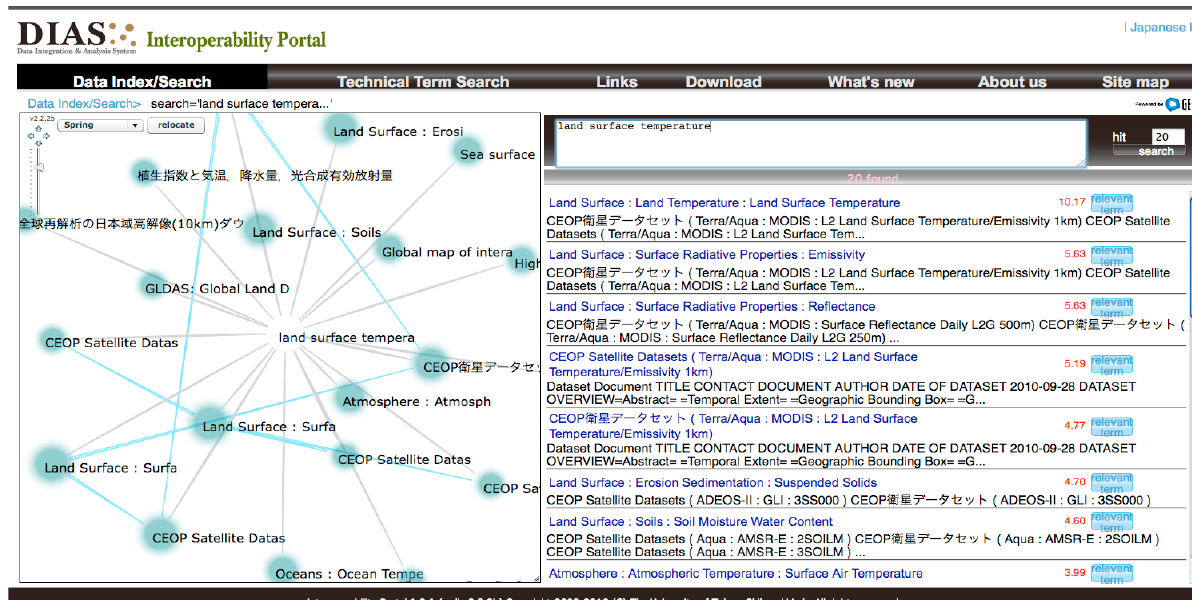
Figure 3. Graph representation